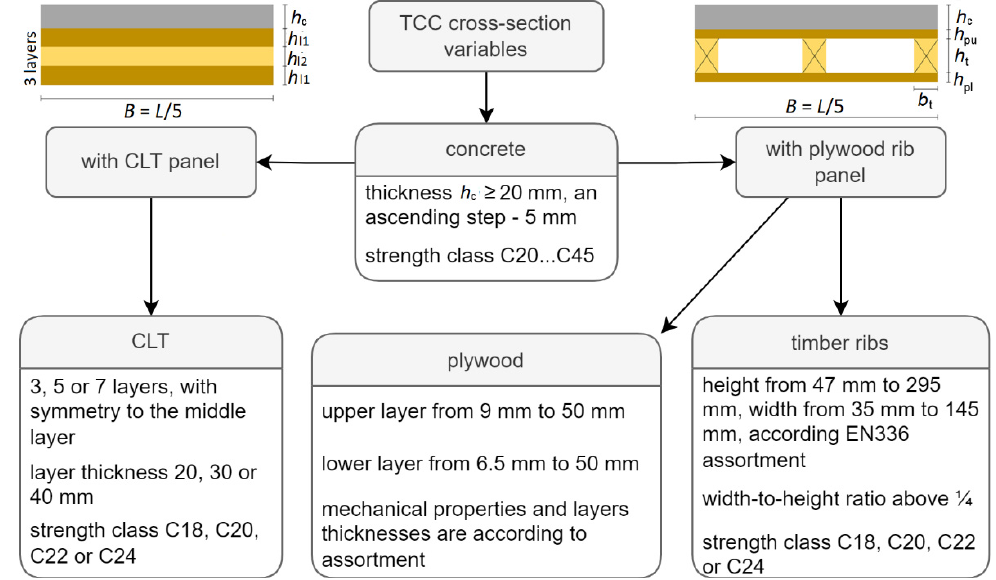
Figure 4. The assumed variables for elements of the TCC cross-section, where B —width of the panel; L —length of the panel; h c —thickness of the concrete layer; h l1 and h l2 —thickness of the CLT layers; h pu and h pl —thickness of the upper and lower plywood layers; b t and h t —width and height of the timber rib.